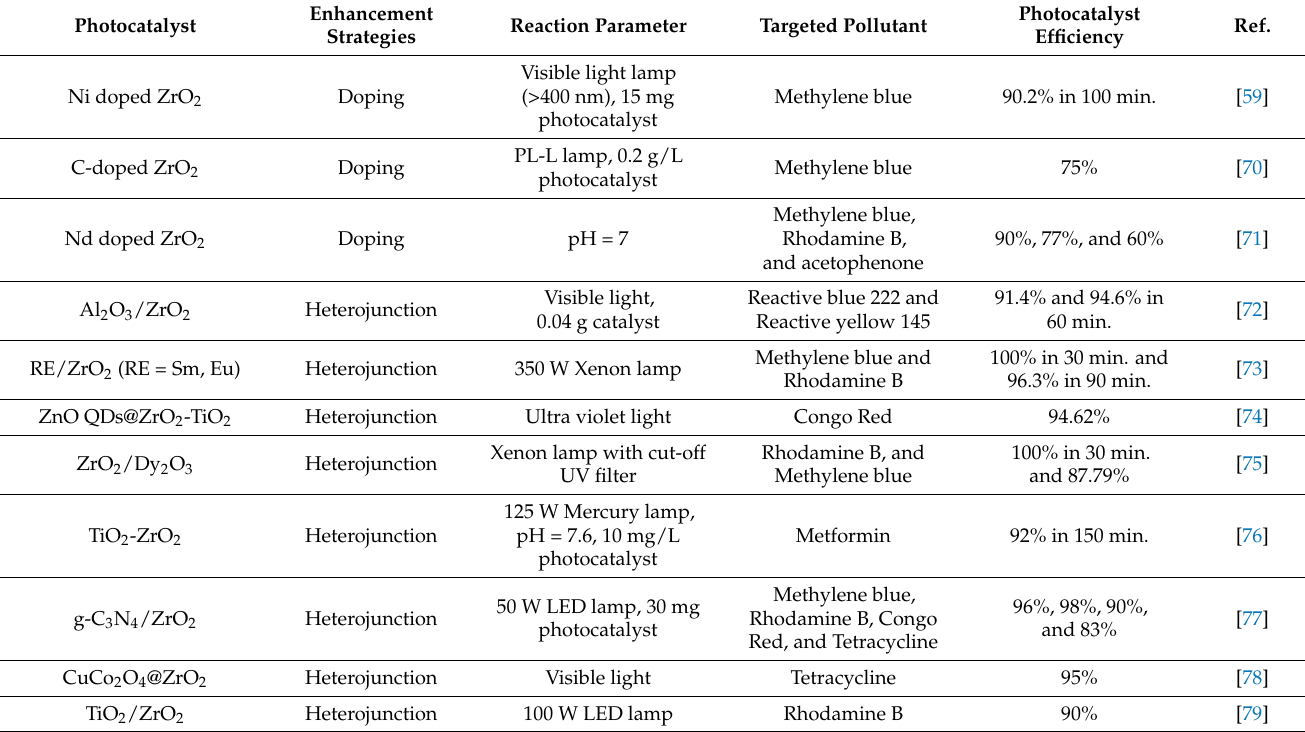
Table 1. Summary of various ZrO 2 -based semiconductor photocatalysts for the incremented photo- catalytic degradation of aqueous phase